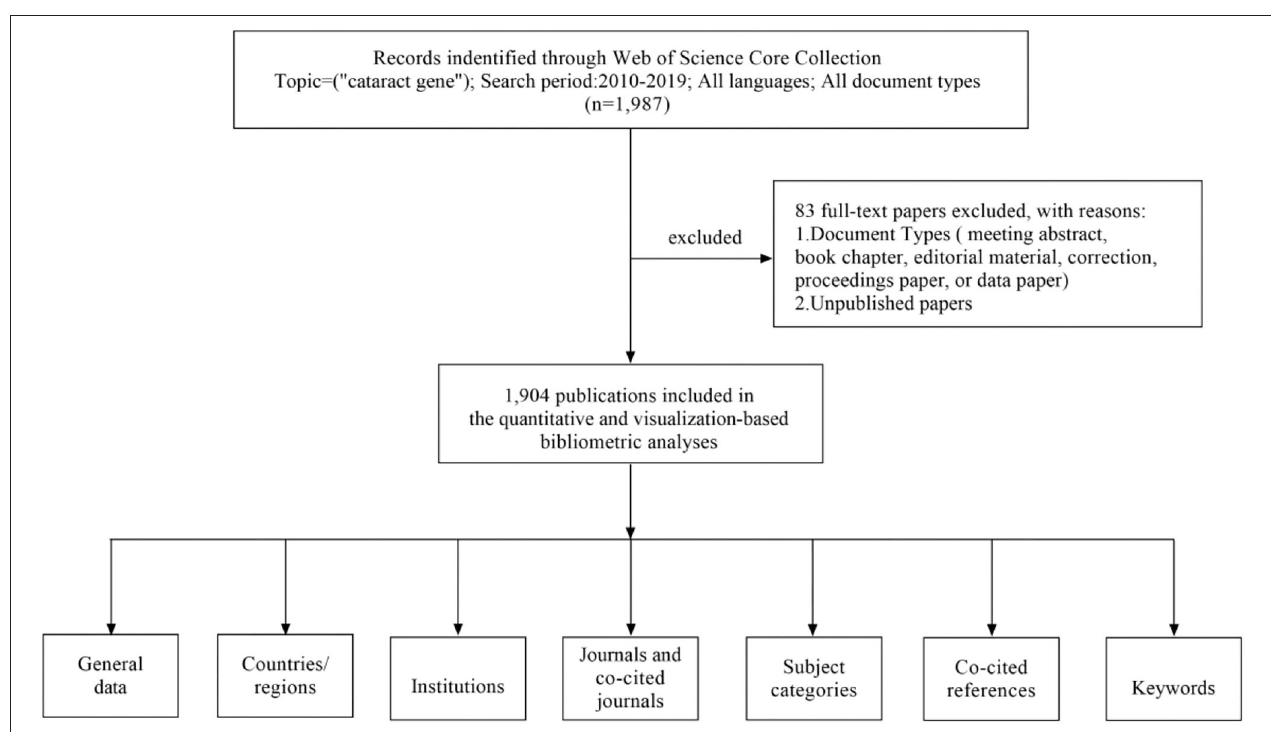
FIGURE 1 | A frame flow diagram. The diagram showed details selection criteria for Cataract gene publications from WoSCC database and the steps of bibliometric analysis.